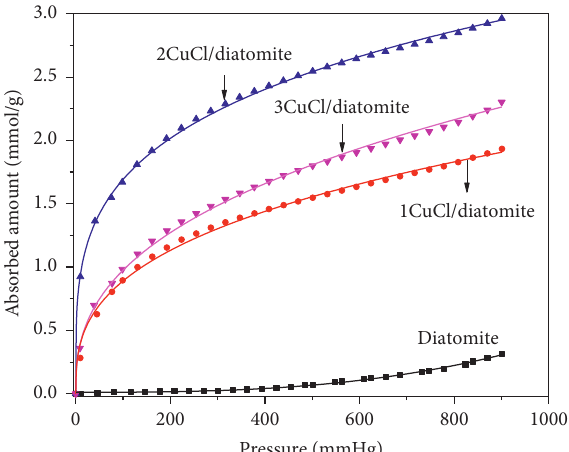
Figure 9: Carbon monoxide adsorption isotherms of diatomite and CuCl-modified diatomites at 30 °